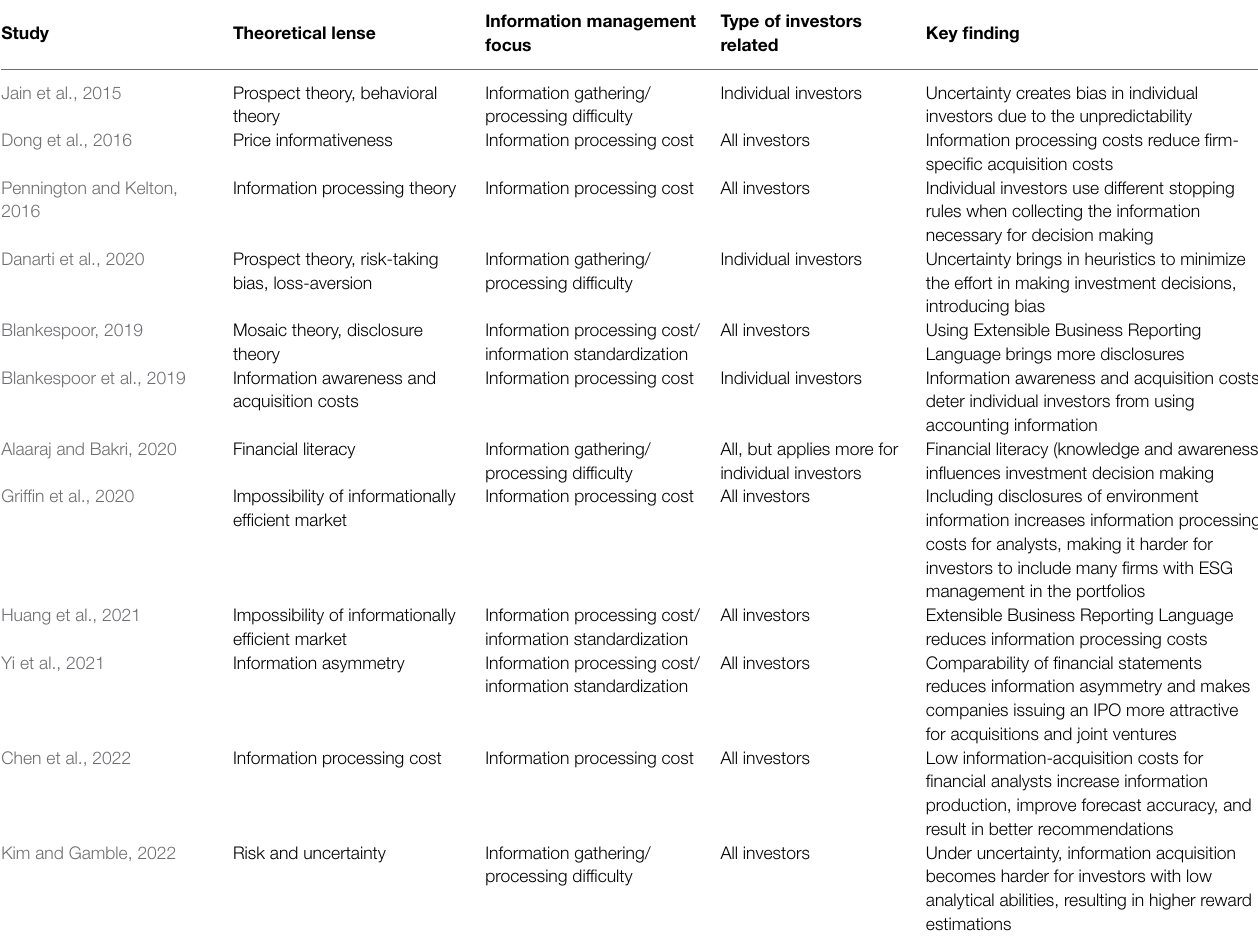
TABLE 2 | Information integration issues using the risk management